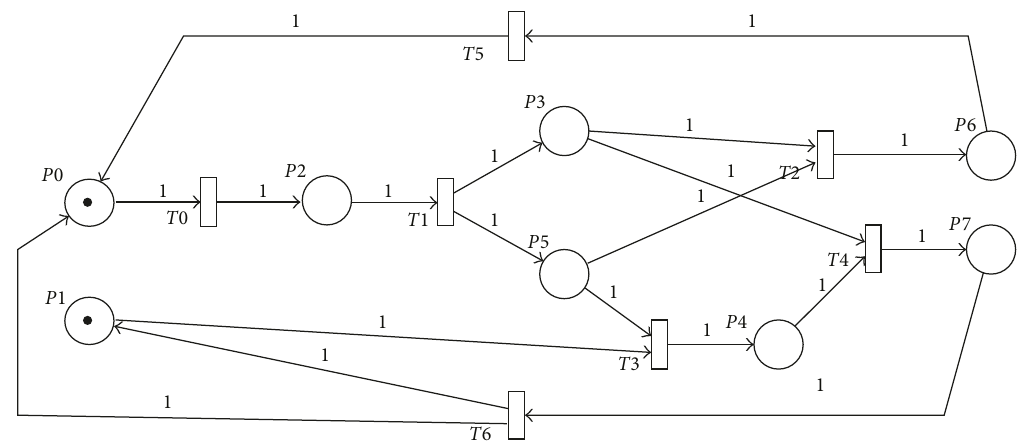
Figure 6: Retrieval process in CSVS system modeling by PIPE